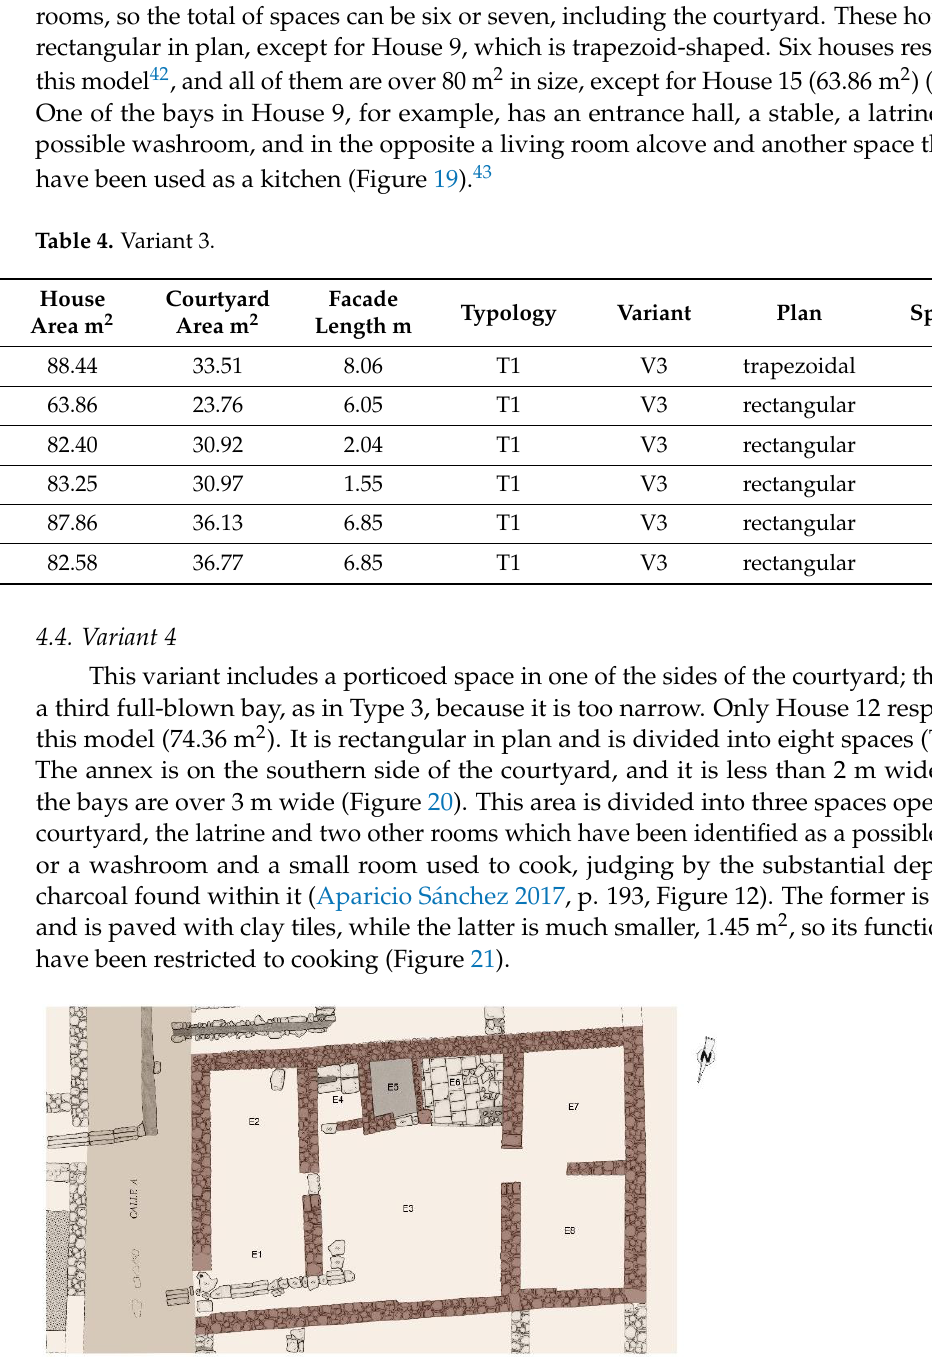
Figure 21. House 12. Spaces of annex: latrine, hearth, and possible pantry or washroom (Aparicio Sánchez 2017, Figure 12). 4.5. Variant 5 It includes the houses with the two opposing bays and a third one attached to one of them. Two houses respond to this model, 105, which is irregular in plan and 71.44 m 2 in size; and 128, which is rectangular in plan and 196.63 m 2 in size; the size difference is mirrored by the number of rooms in each, six in the former and nine in the latter (Table 6). Table 6. Variant 5. Household Units